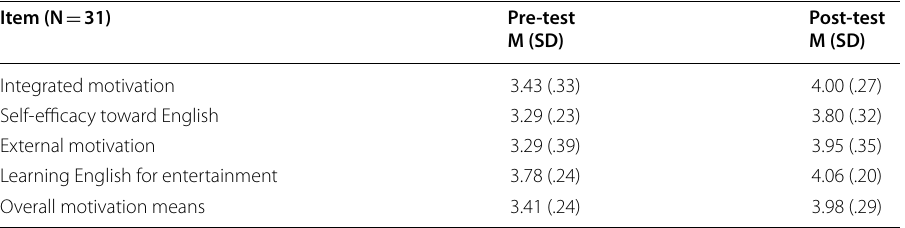
Table 7 L2 motivation rating scale (experimental group)